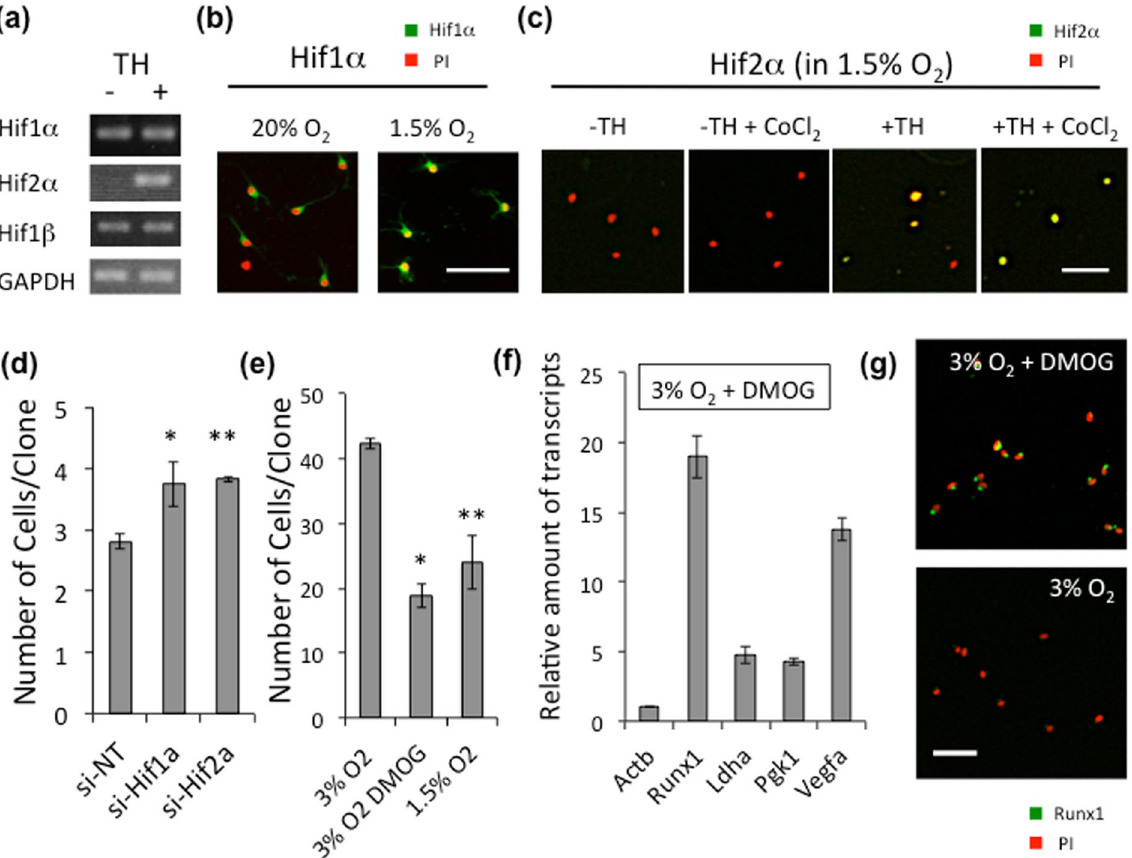
Figure 6. Stabilization of Hif α proteins permits TH-dependent Runx1 gene expression. ( a ) P7 OPCs cultured in 1.5% O 2 in PDGF, with ( + ) or without TH ( − ), for 15 days were assayed gene expressions of Hifs by RT-PCR. ( b ) P7 OPCs were cultured in 20% O 2 in PDGF without TH for 7 days, and some were then changed to 1.5% O 2 for 20 hours. The cells were labeled with rabbit anti-Hif1 α antibodies ( green ) and PI ( red ). Scale bar: 50 μ m. ( c ) P7 OPCs were cultured in 1.5% O 2 in PDGF with ( + TH) or without TH ( − TH) for 10 days. The cells were labeled with rabbit anti-Hif2 α antibodies ( green ) and PI ( red ). To prevent the degradation of Hif2 α protein, some cultures were treated with 0.2 mM of CoCl 265 for last 7 hours. Scale bar: 50 μ m. ( d ) P7 rat OPCs were cultured without TH in 1.5% O 2 conditions for 12 days, then co-transfected with anti-Hif1 α siRNA or anti- Hif2 α siRNA and pMaxGFP. Cells were cultured with TH in 1.5% O 2 conditions for another 4 days. The number of GFP + cells in each clone was counted. si-NT; non-target siRNA, si-Hif1a; anti-Hif1 α siRNA, si-Hif2a; anti- Hif2 α siRNA. * P < 0.05, ** P < 0.01. ( e ) Freshly prepared OPCs from P7 rat optic nerve were cultured with TH in 1.5% O 2 or 3% O 2 conditions. For several flasks in 3% O 2 , DMOG (1 mM) was added. After 7 days, the number of cells in each clone was counted. * P < 0.005, ** P < 0.05. ( f ) P7 rat OPCs cultured in 3% O 2 with TH were treated with DMOG (1 mM) for 24 hours. Then qRT-PCR analysis was carried out. Results were presented as the relative amount of transcripts to that of the DMOG free culture using comparative ∆∆ Ct method. Actb is an endogenous negative control. Ldha , Pgk1 and Vegfa are HIFs-inducible positive control. The P values of these genes are P < 0.001 (ANOVA with Fisher’s LSD test, n = 3). ( g ) After 24 hours of DMOG treatment, OPCs (3% O 2 + TH) were stained with rabbit anti-Runx1 antibodies ( green ) and PI ( red ). Scale bars; 50 μ